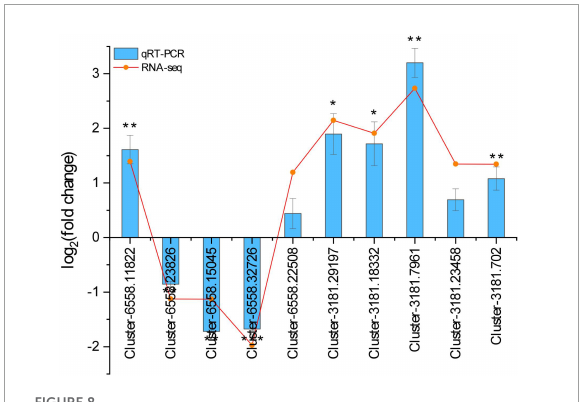
FIGURE8 The relative expression levels of 10 DEGs between RNA-seq and qRT-PCR. The gene relative expression levels were determined by the 2 – (cid:49)(cid:49) CT method. RNA-seq, RNA sequencing; qRT-PCR, quantitative real-time polymerase chain reaction. All statistical analyses of data were performed using SPSS software (version 26, IBM, Chicago, IL, United States) to assess significant differences ( n = 3). Significance was defined as *( P < 0.05), **( P < 0.01), and ***( P <